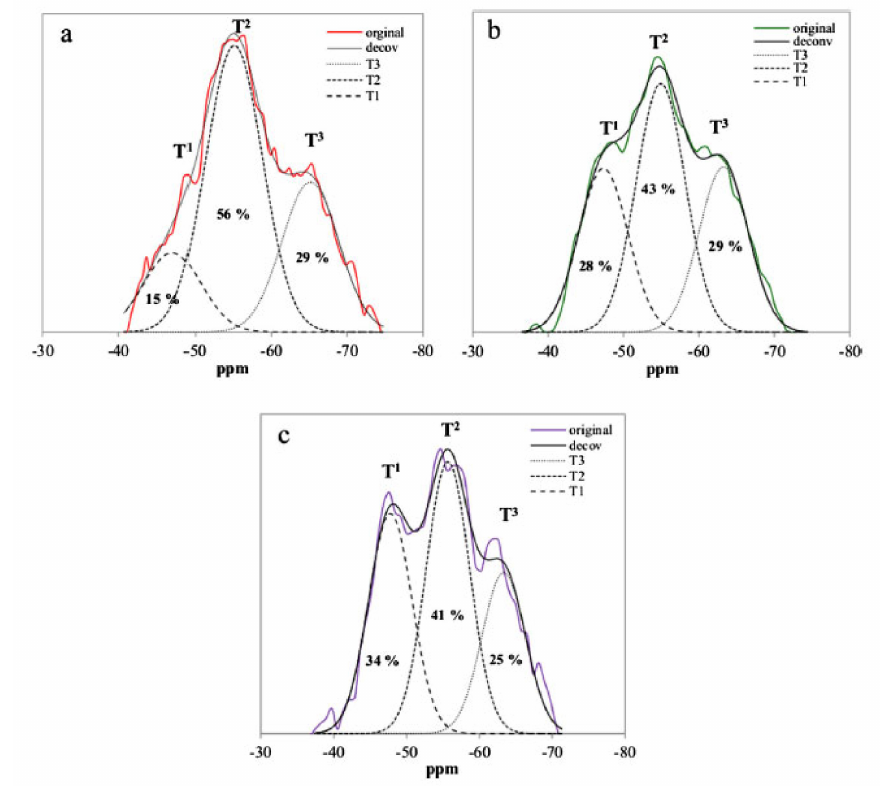
Figure 16. 29 Si CP/MAS NMR spectra of modified catalysts and resulting deconvolution bands for: ( a ) commercial alumina catalyst ACTS, ( b ) Synthesized alumina catalyst ASmTS and ( c ) sol-gel BSmTS, from ref [79]. Reprinted with permission from ref. [79]. Copyright 2017